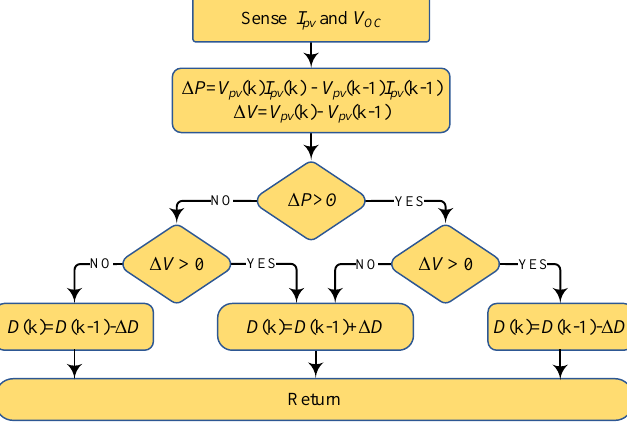
Figure 5. The flowchart of the P&O tracking